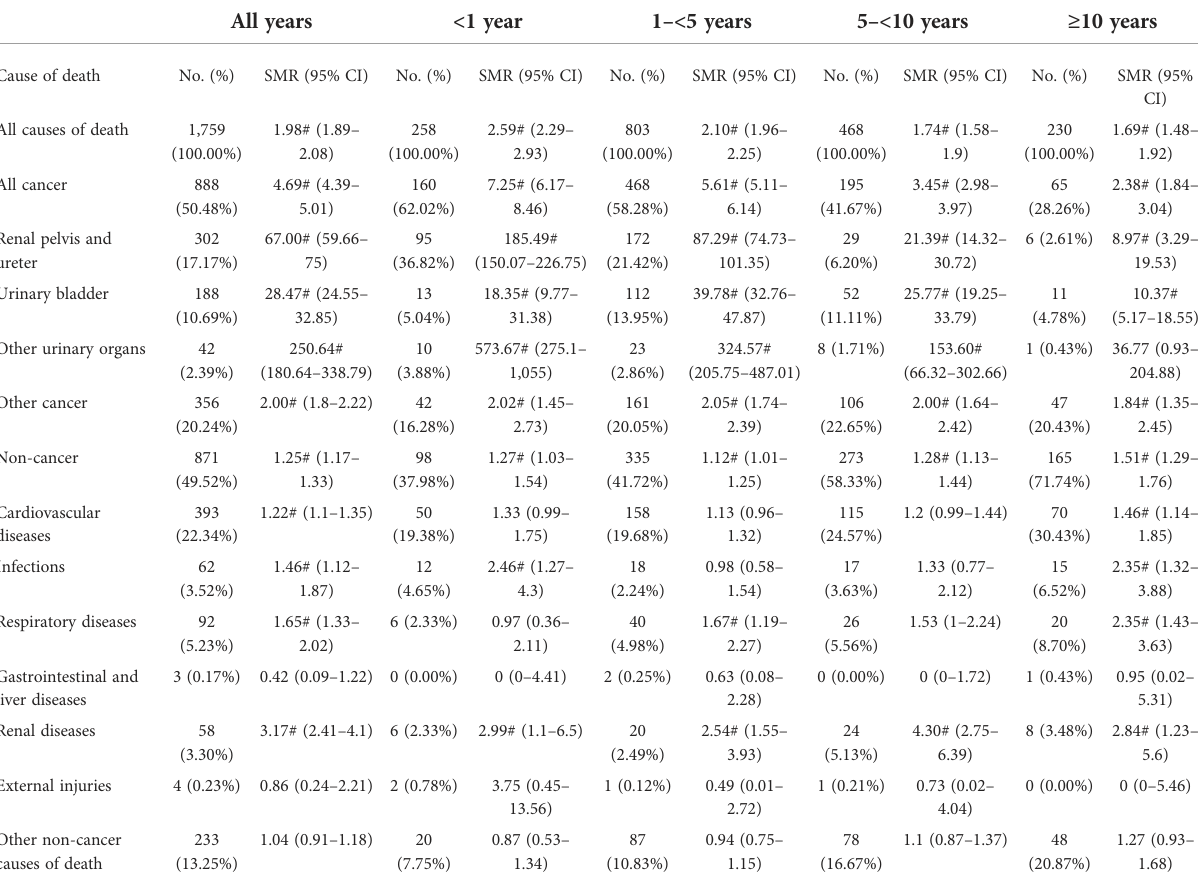
#p<0.05; SMRs, standardized mortality ratios; CI, con fi dence